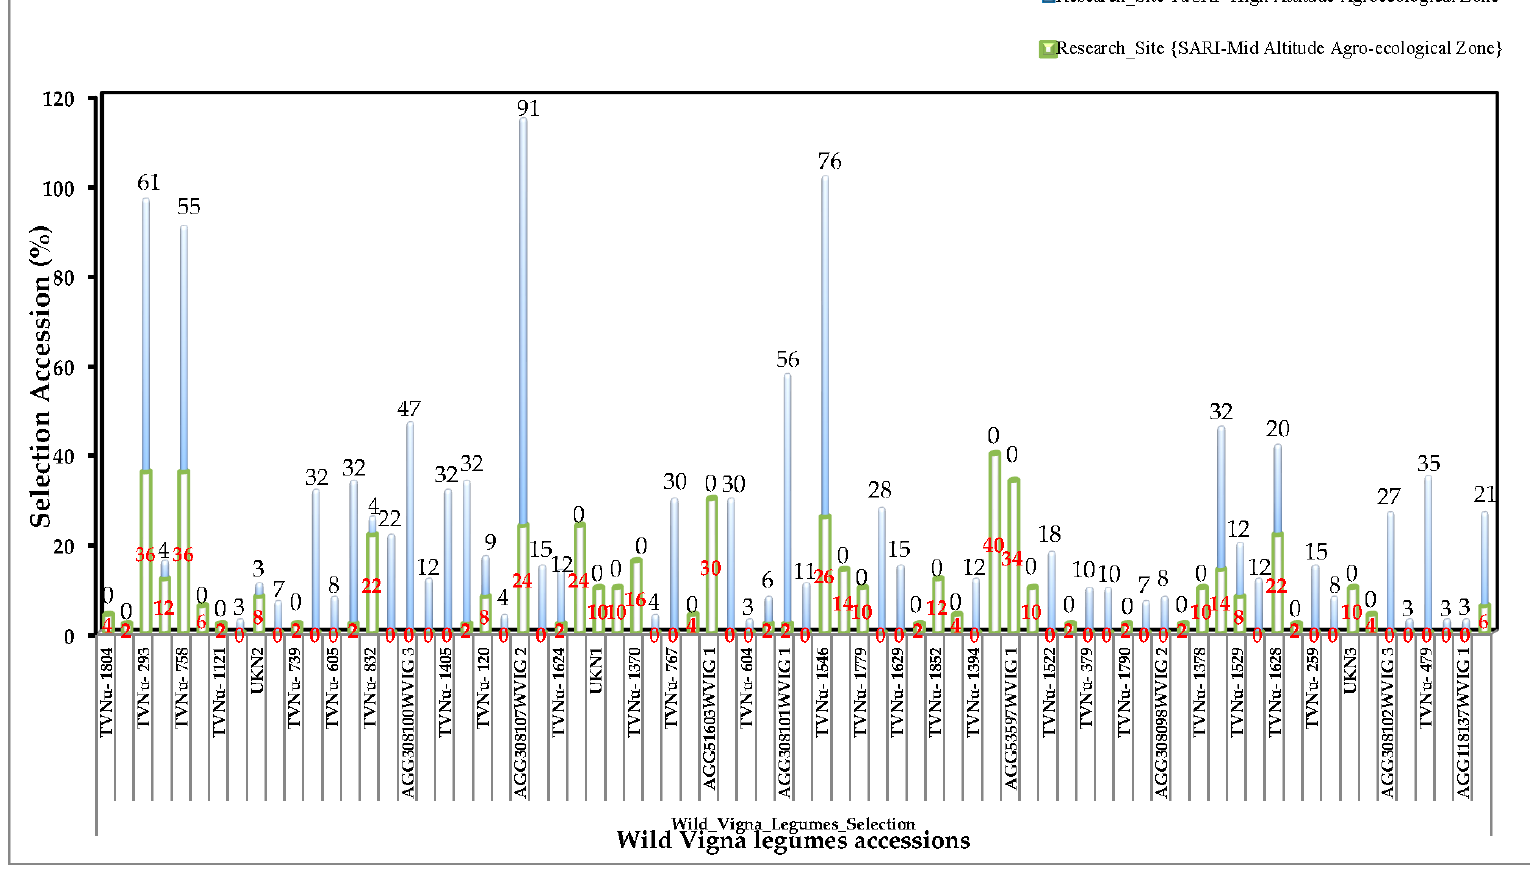
Figure 6. Wild Vigna legumes preferred (selected) by participants from the two agro-ecological zones.